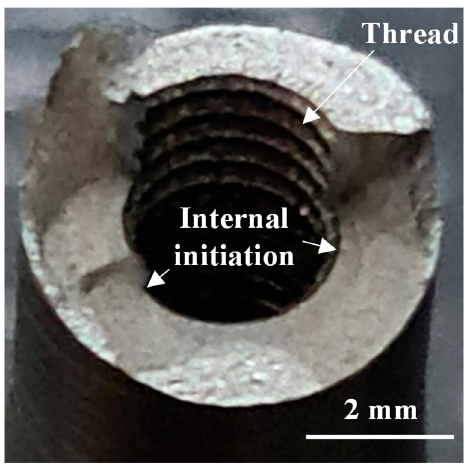
Figure 6. Fracture surface of hole threaded, σ a = 80 MPa.